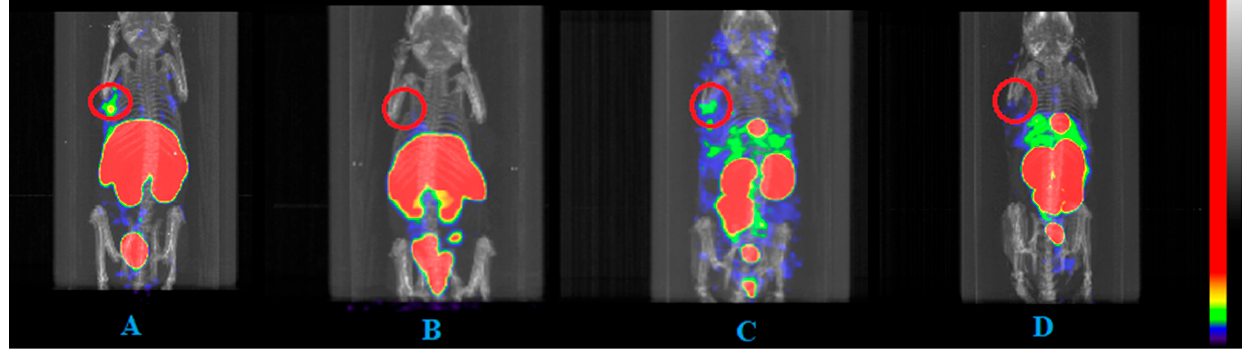
Figure 5. ( A ) SPECT/CT images of [ 99m Tc]Tc-CN5FA in KB tumor-bearing mice and ( B ) the blocking study at 2 h p.i.; ( C ) SPECT/CT images of [ 99m Tc]Tc-CNPFA in KB tumor-bearing mice and ( D ) the blocking study at 2 h p.i.